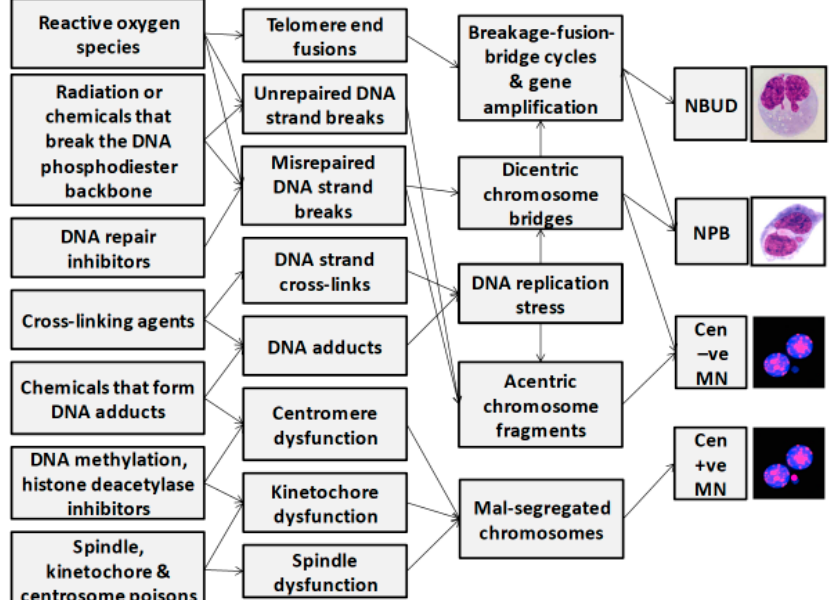
Figure 1. Molecular mechanisms that lead to the formation of micronuclei (MNi), nucleoplasmic bridges (NPBs), and nuclear buds (NBUDs) in lymphocytes. Cen + ve, centromere positive; Cen − ve, centromere negative.